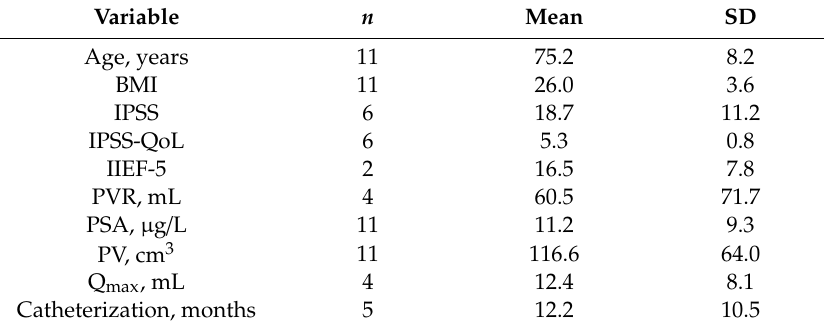
Table 1. Baseline characteristics.